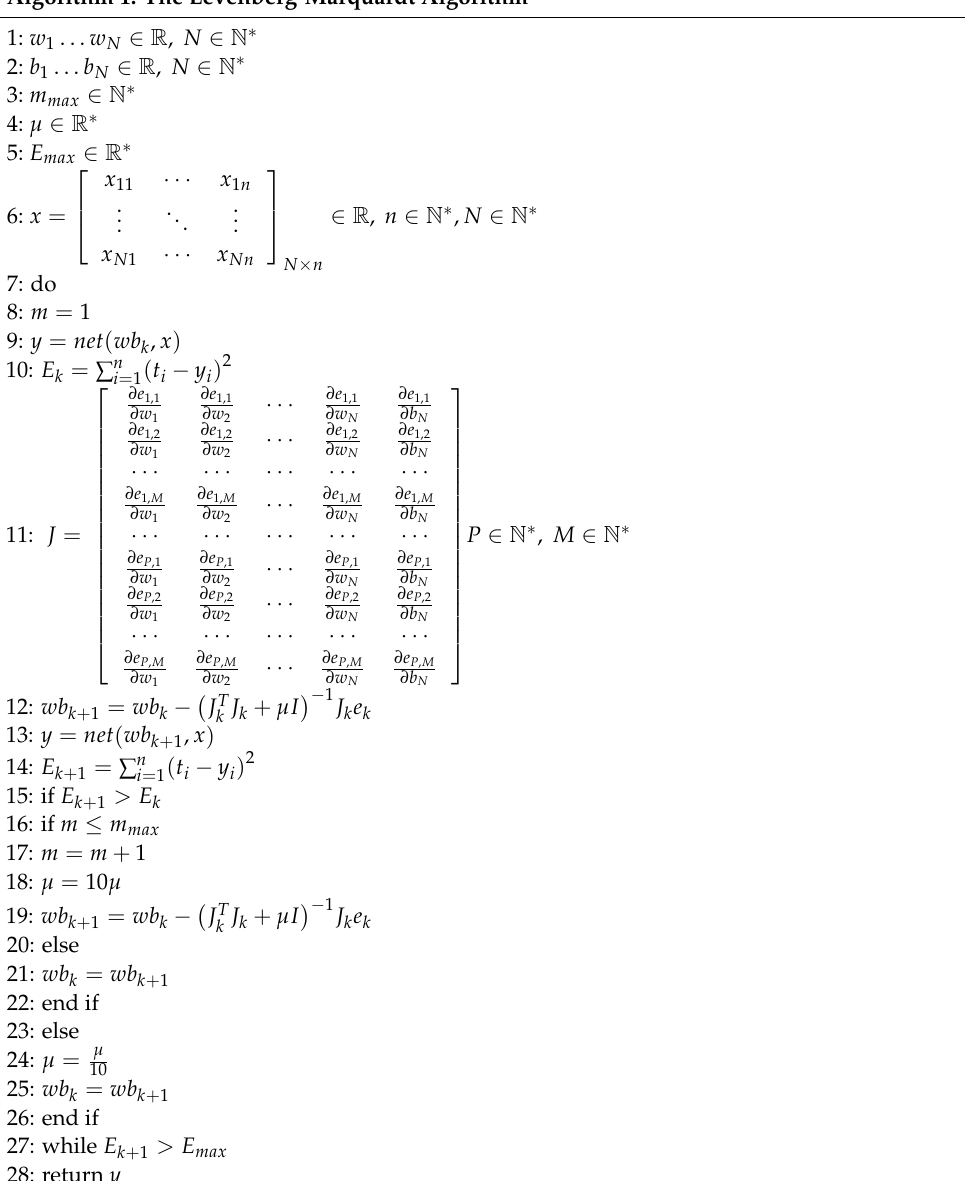
Algorithm 1: The Levenberg-Marquardt